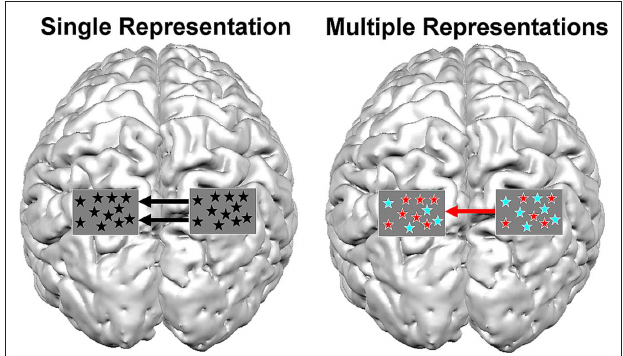
Figure 3 | Possible scenarios for brain connectivity under the assumption of single representation and multiple representations. A picture of a brain is shown from a top view. The rectangles over parietal lobes represent a magnification of voxels in the IPS and the type of representation within them. In the case of a single representation, format-independent representation exists in the IPS (black asterisks). In such a case the communication between the left and right IPS should be independent of format (i.e., digits or dots). In this example, the activation in the right IPS modulates the activation in the contralateral IPS. In contrast, the multiple representations hypothesis predicts that if different representations exist in the IPS, the activation between both IPS should be format-dependent. In the current example, the right IPS modulates the activity in the left IPS for dots (red asterisks), but not for digits (turquoise asterisks). The current figure is only an example, and is a simplified version of possible connectivity that can occur between the hemispheres, and does not discuss possible connectivity that can occur within